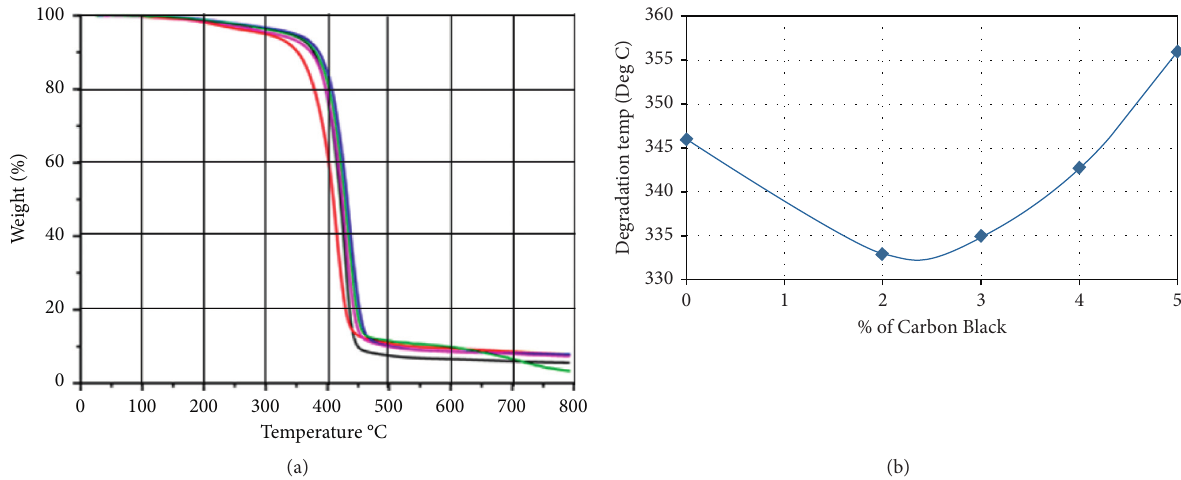
Figure 3: (a) Effect of carbon black on thermal stability (% of degradation) of the vinyl ester composites. (b) Effect of carbon black on degradation temperature of the vinyl ester